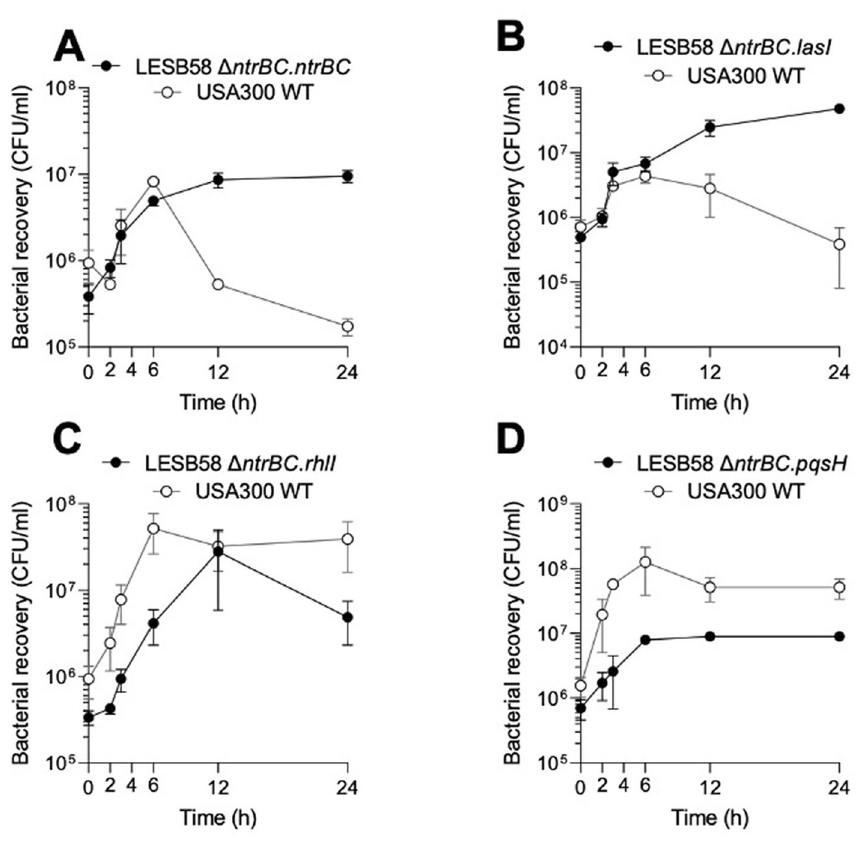
Figure 6. Competitive phenotype of P. aeruginosa LESB58 Δ ntrBC could be phenotypically complemented. Phenotypic complementation by ( A ) ntrBC and ( B ) lasI , but not ( C ) rhlI or ( D ) pqsH . P. aeruginosa LESB58 Δ ntrBC strains were seeded with S. aureus USA300 at starting OD 600 = 0.1 in cultures that were sampled in 2-, 6- or 12 h intervals and plated on selective media for bacterial enumeration. Data are presented as mean ± standard error of the mean (SEM) for three independent experiments ( n =